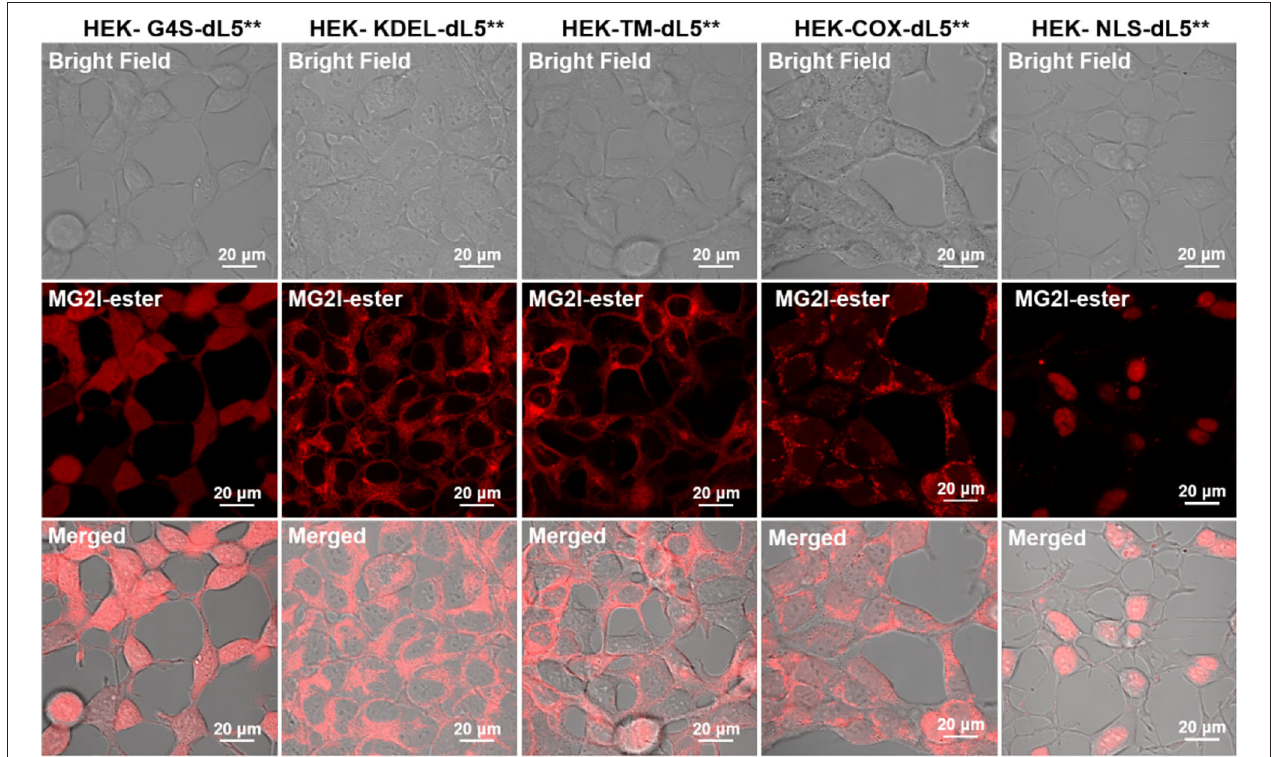
FIGURE 2 | Confocal fluorescence images of five different dL5**-expressing HEK cells incubated with MG2I-ester (500nM, Ex = 633nm, 64 × ). These constructs have been validated for localization previously, and the patterns observed in these experiments are consistent with proper localization. For the TM construct, the MG2I-ester, being a cell-permeant fluorogen, labels both the plasma membrane and secretory pathway, including ER, Golgi, and endolysosomal locations. High-resolution images are included as Supplementary Figures 1–5 .